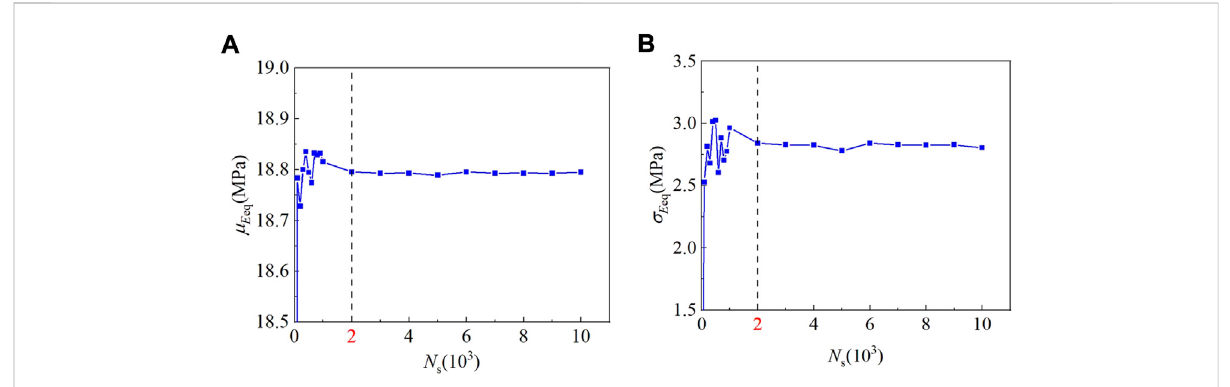
FIGURE 14 Variation of (A) μ Eeq and (B) σ Eeq with N s